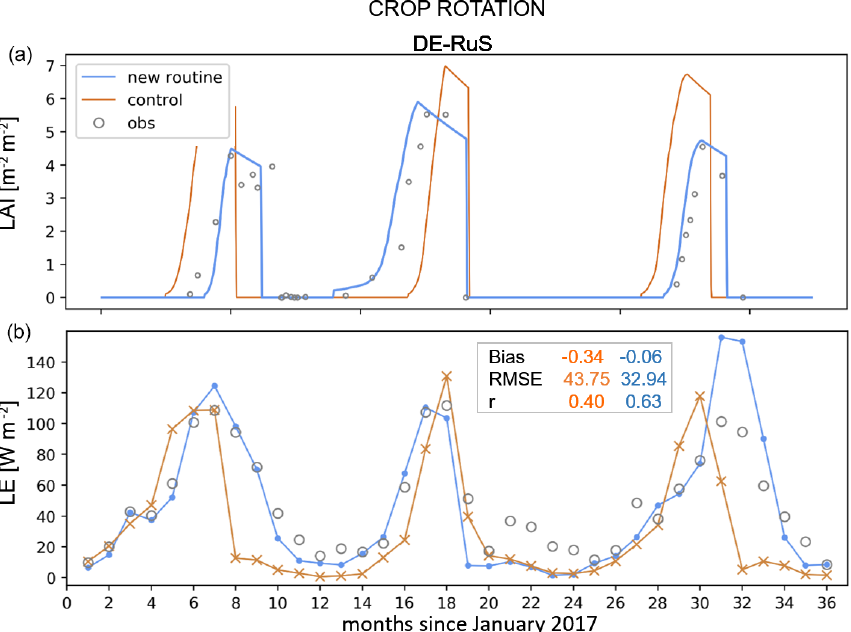
Figure 8. (a) Simulated LAI for crop rotation from sugar beet (2017), winter wheat (2017/2018), and potatoes (2019) at DE-RuS using the new cover-cropping subroutine (blue) in comparison to control simulation results with the default phenology algorithm of CLM5 (orange). (b) Corresponding monthly averaged simulation results for the latent heat flux with respective bias, RMSE, and r over the whole time interval (calculated using simulation output and observation data at daily time step). Available observation data are plotted in